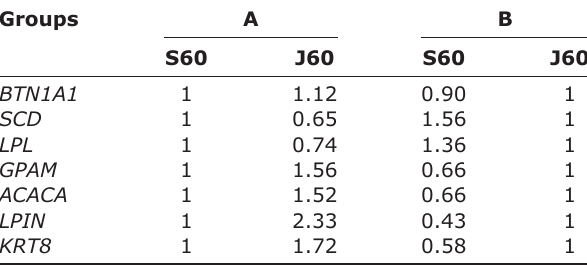
Table-5: Folds increase/decrease in major milk lipogenic genes and keratin gene transcripts among different